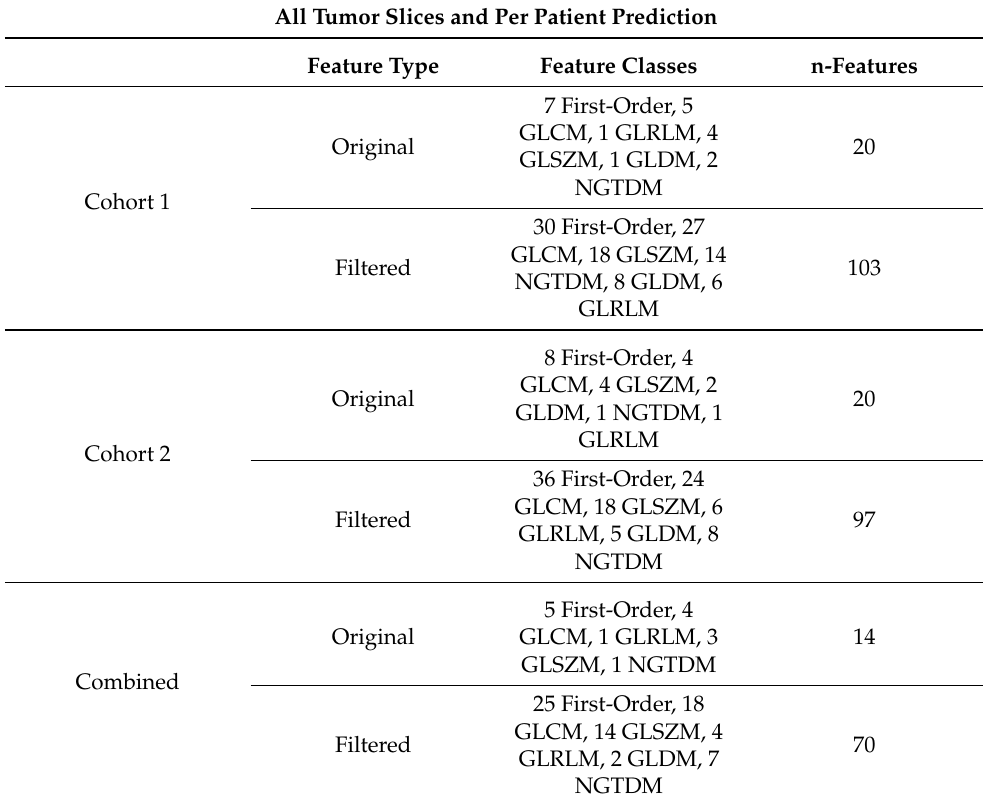
Table 5. Representation of robust features selected for All Tumor Slices and Per Patient